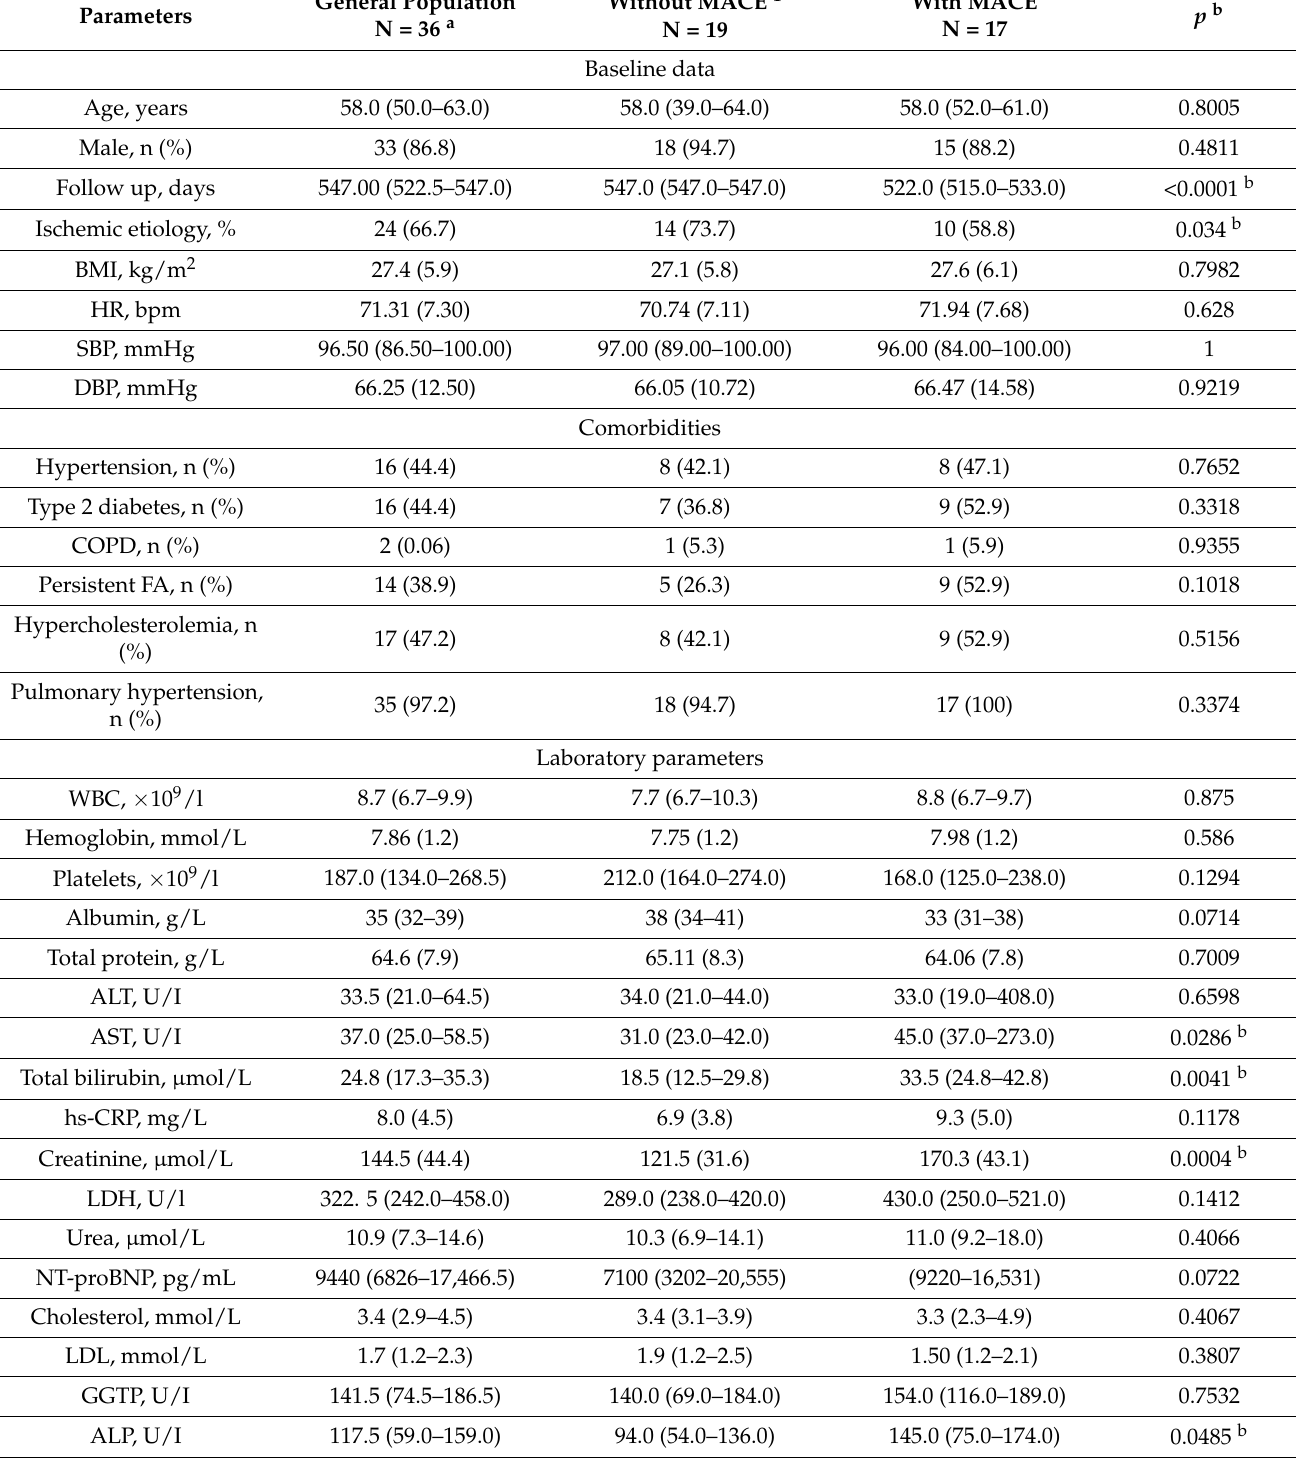
Table 1. Baseline characteristics of the patients before LVAD